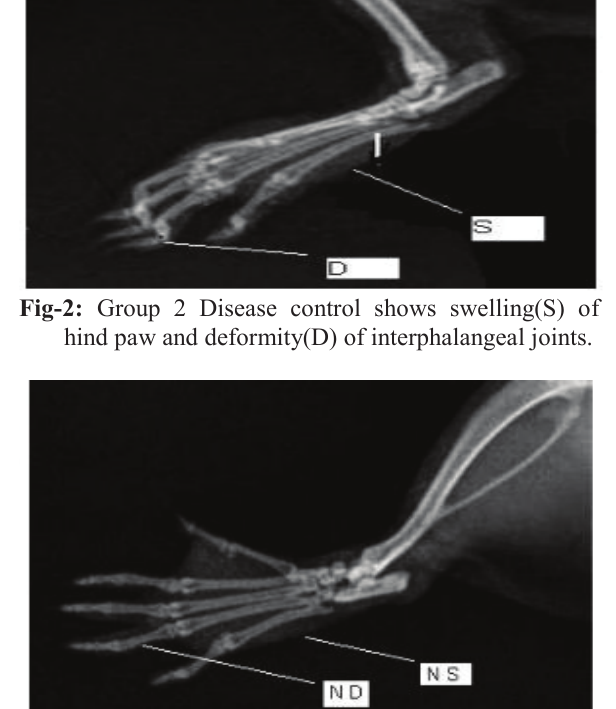
Fig-7: Prophylactic Group 7 Methalonic extract of Cassia fistula 500mg/kg showing low swelling of hind paw and low deformity of interphalangeal joints. Improvement in joint space and cartilage deformity.